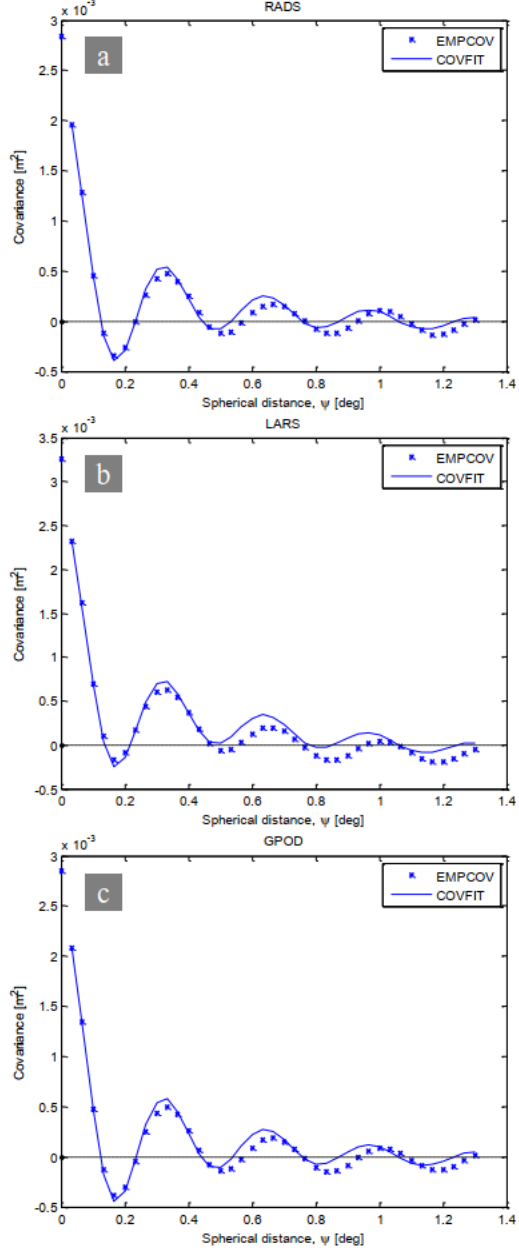
Fig. 3. Residual height anomaly after cross-over adjustment (a) RADS (b) LARS (c) GPOD. Only EGM2008 (d/o 1080) is removed.